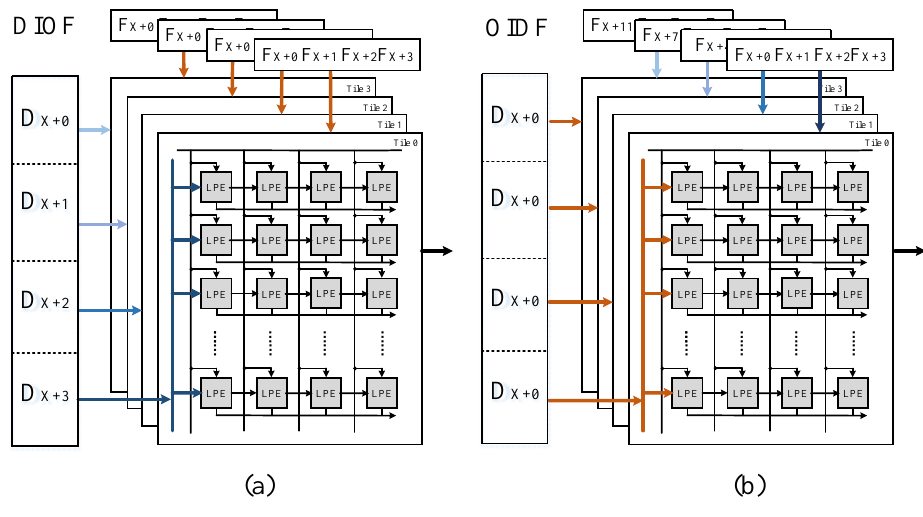
Figure 7. ( a ) DIOF dataflow, ( b ) OIDF